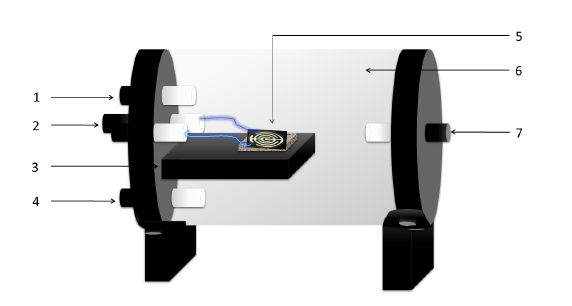
Figure 2. Sensing reactor scheme. 1. Gas input, 2. Electric connections, 3. Sensor holder, 4. Temperature measurement, 5. Sensor, 6. Sealed reactor (quartz), 7. Gas exhaust. The characterizations were made in darkness at 27 ◦